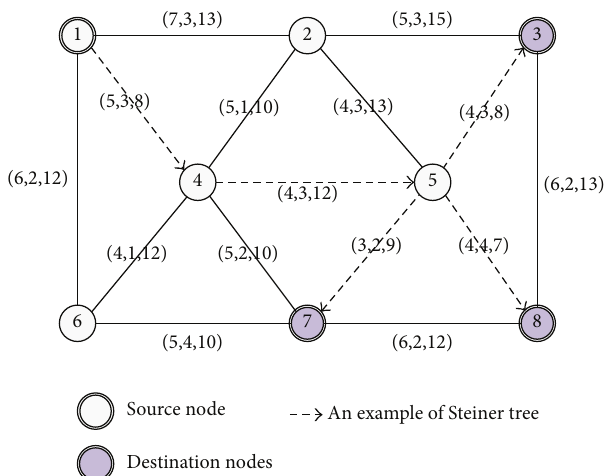
Figure 1: An example of a network graph, link parameters, and a Steiner tree.